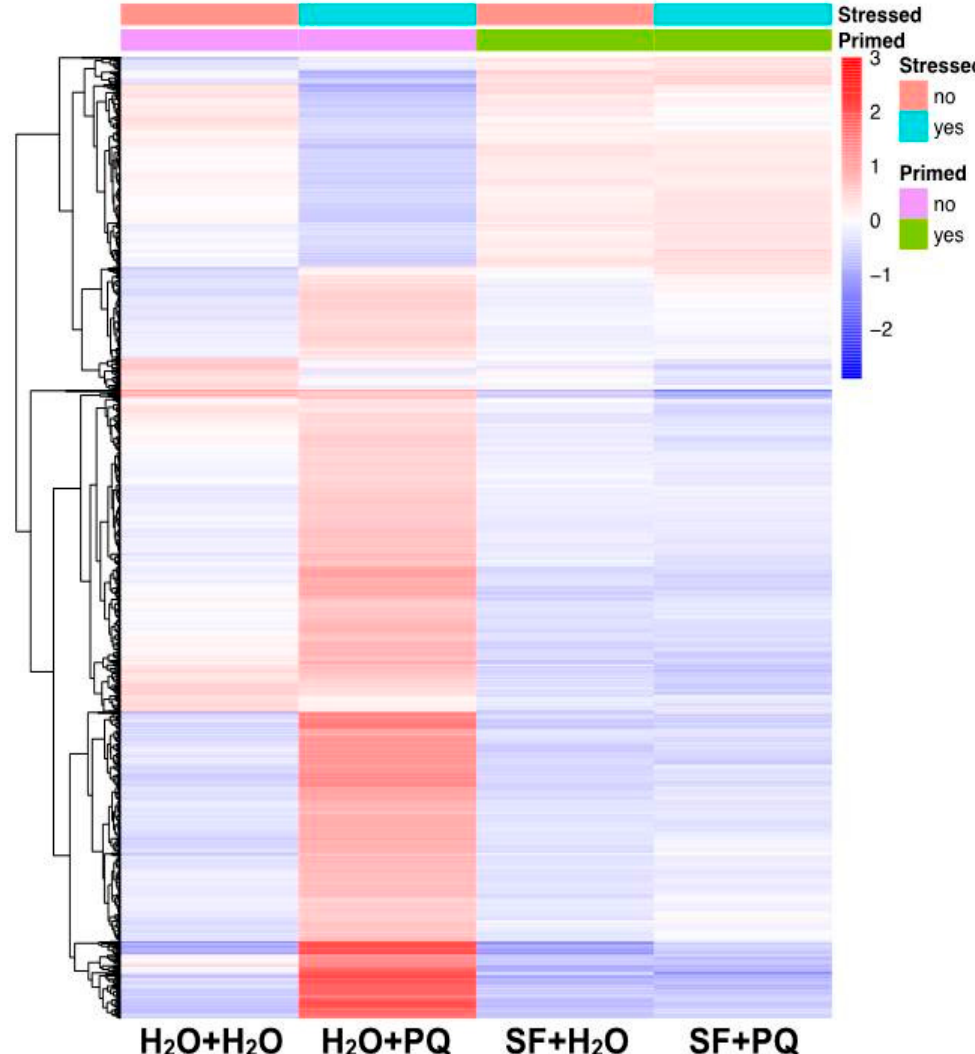
Figure 4. Transcriptional regulation upon PQ stress in SF-primed and unprimed Arabidopsis plants. Heatmap of all differentially expressed genes. Color scale represents the mean centered log 2 normalized TMM values (Trimmed Mean of M values) averaged across three biological replicates. Full data are given in Supplementary Materials Data S1 and S2.